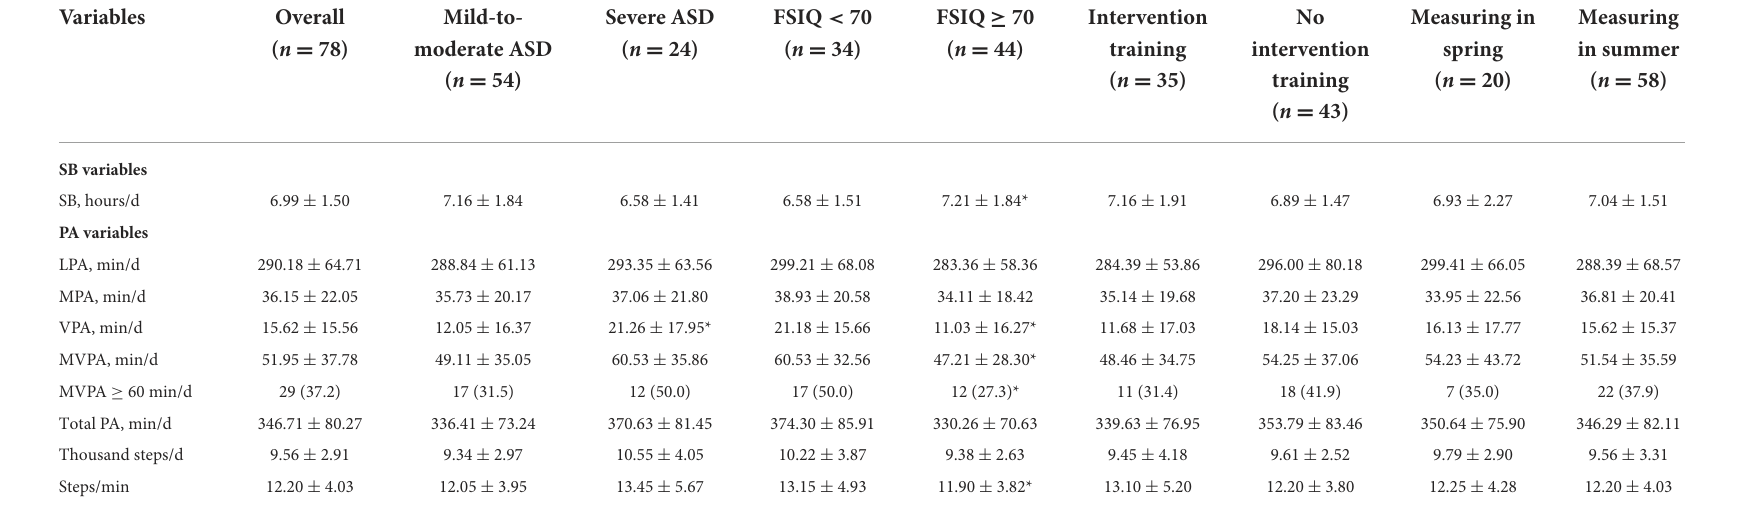
TABLE 2 Sedentary behavior, physical activity, and step counts in children with ASD ( n = 78).